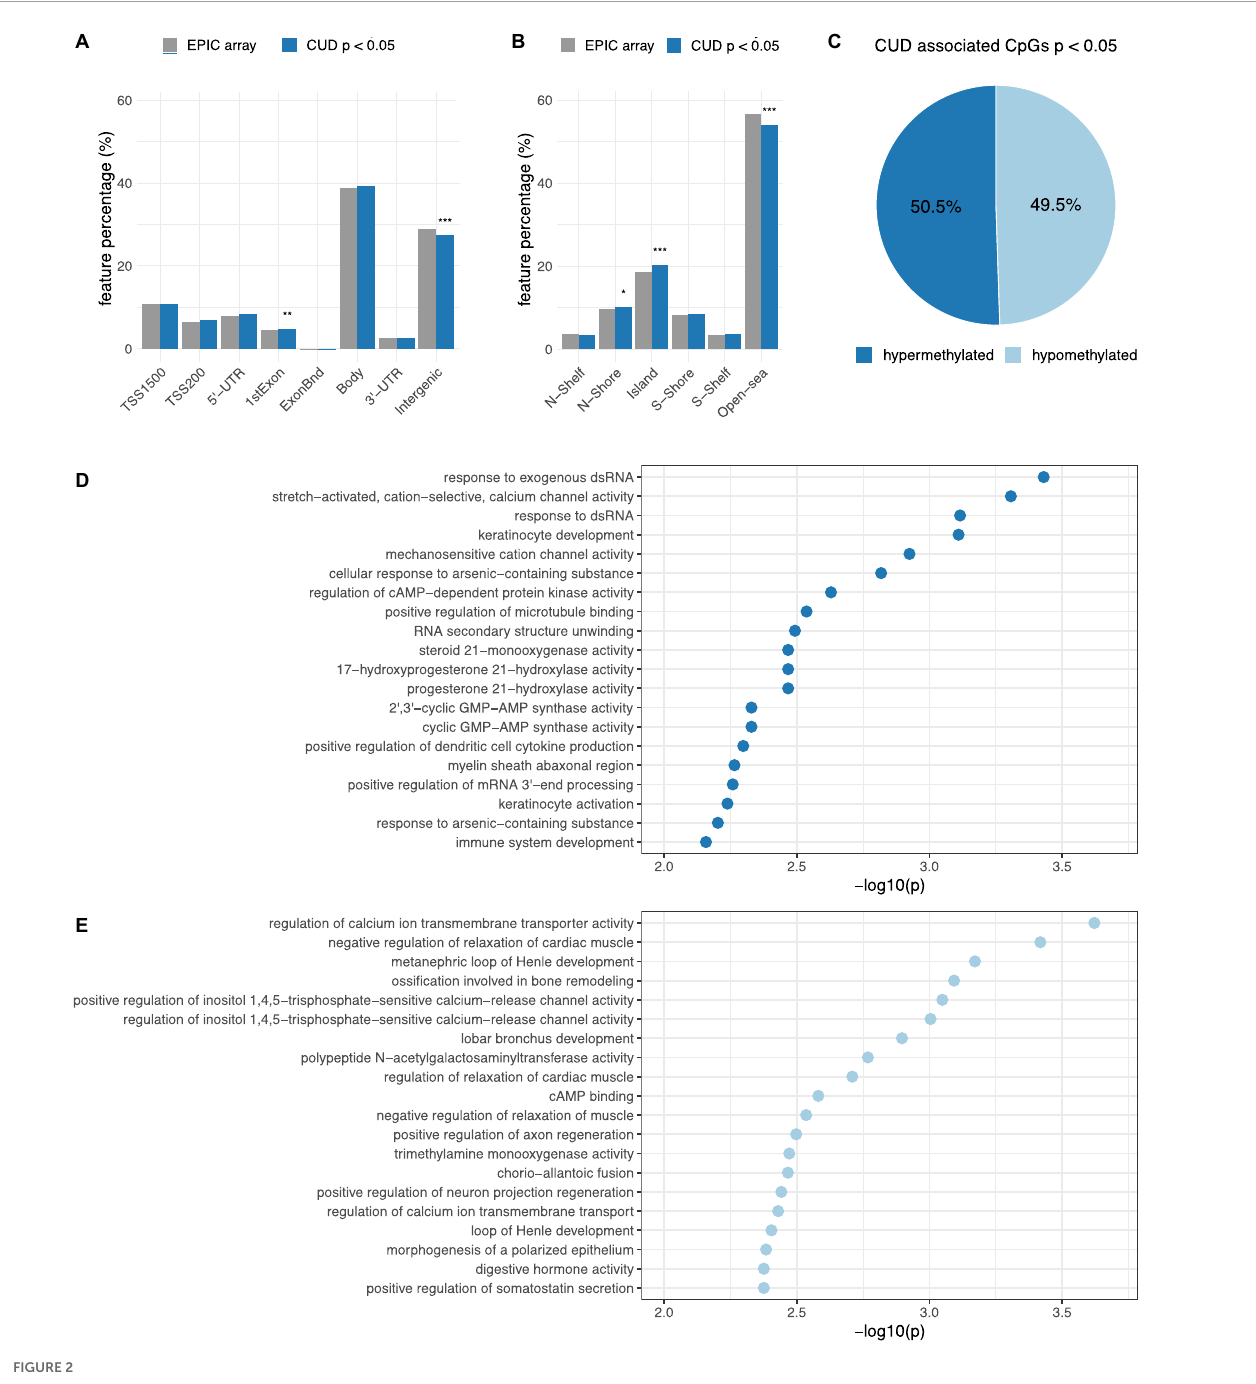
FIGURE2 Results from the epigenome-wide association study (EWAS) of CUD were prioritized based on association p -values resulting in a subset of N = 29,176 CpG sites with p assoc < 0.05 that was further analyzed by annotation to panel (A) gene regulatory features and (B) the CpG island (CGI) background. The proportion of CUD-associated CpG sites (blue) within different groups was compared to the EPIC array background (gray). Differences remaining statistically significant after Bonferroni multiple testing correction are highlighted using asterisks (* = p adj < 0.05, ** = p adj < 0.01, *** = p adj < 0.001). (C) Hypermethylation (light-blue) and hypermethylation (dark blue) among the N = 29,176 CUD-associated CpG sites. The top 20 CUD-associated GO terms resulting from missMethyl (42) are shown for (D) hypermethylated and (E) hypomethylated CpG sites associated with CUD ( p <